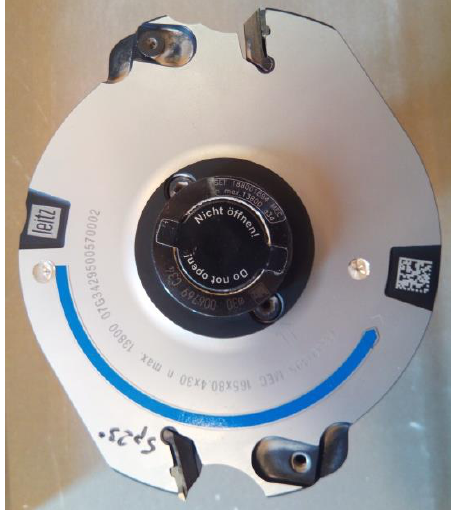
Figure 1. Milling head used in experiment.